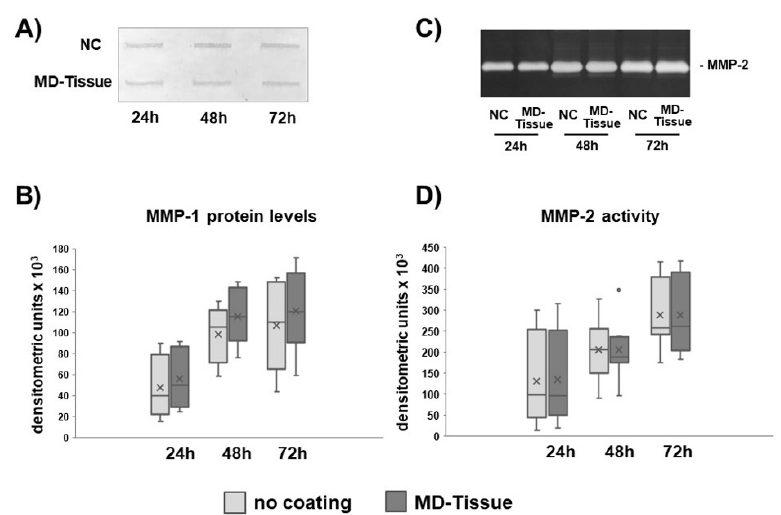
Figure 5. Representative slot blot for matrix metalloproteinase-1 (MMP-1) levels ( A ) and representative SDS-zymography showing MMP-2 activity in serum-free cell supernatants of NC and MD-Tissue tenocytes. Bar graphs showing MMP-1 protein levels ( C ) and MMP-2 activity ( D ) after densitometric analysis of immunoreactive and lytic bands, respectively. Data obtained from the eight samples are expressed as a % of densitometric units vs NC and are ± SD. NC: no coating. ×: mean; •: outlier sample.